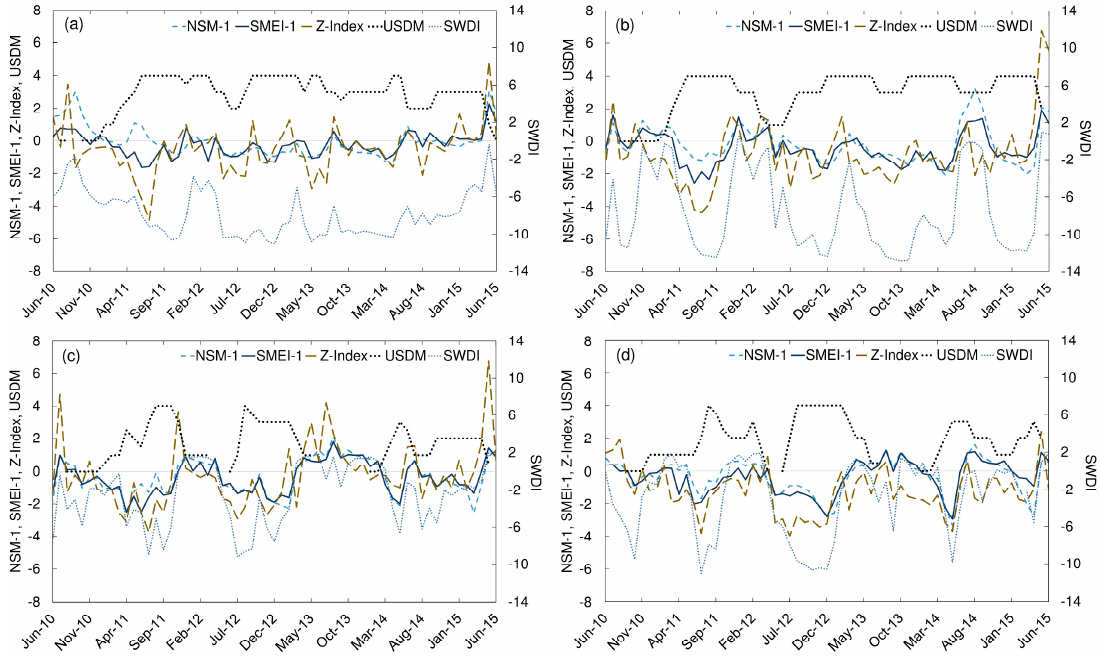
Figure 5. Time series of drought indices at Goodwell ( a ); Hollis ( b ); El Reno ( c ); and Pawnee ( d ).